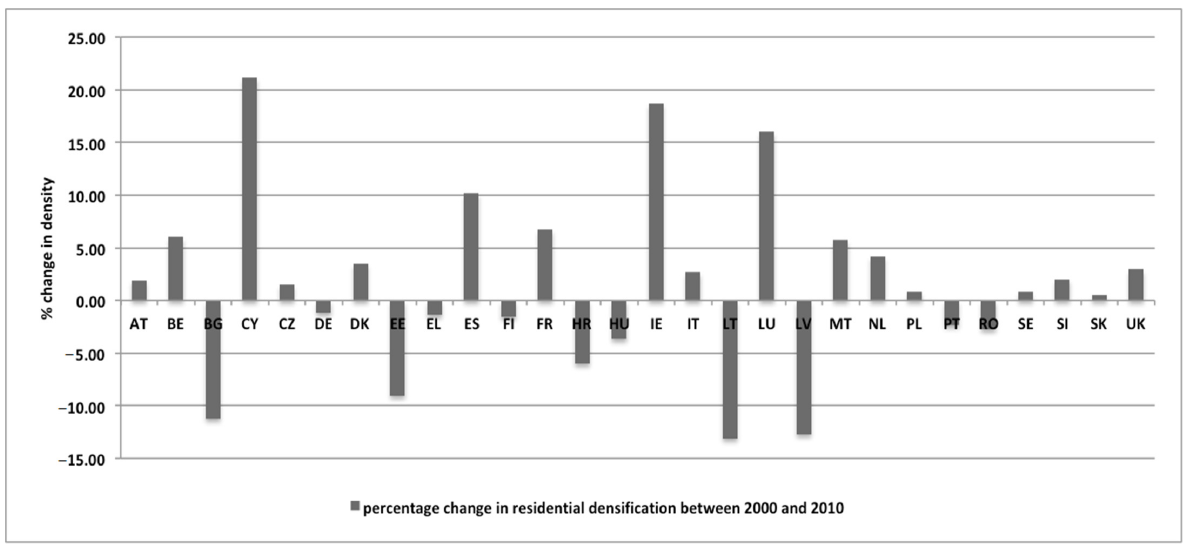
Figure 5. Percentage change in residential densities between 2000 and 2010 in